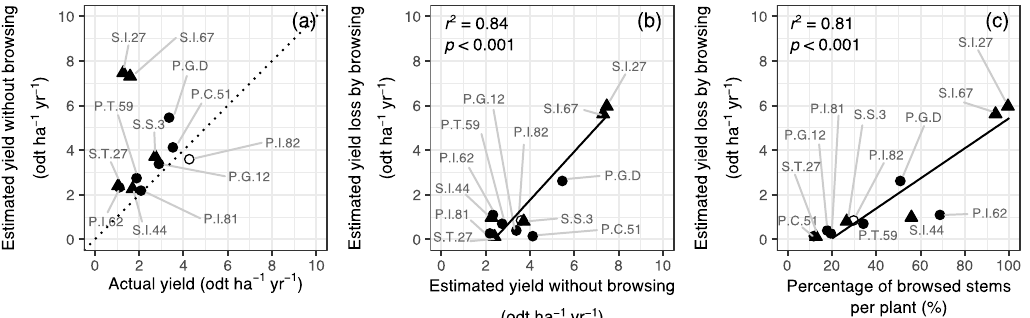
Figure 5. Relationships between actual and estimated yield without deer browsing ( a ), between estimated yield without browsing and estimated yield loss due to browsing ( b ), and the percentage of browsed stems per plant and estimated yield loss due to browsing ( c ) across willow clones. An open symbol represents the clone that was determined to be an outlier based on the GLM residuals. Clone names are shown. The coefficient of determination ( r 2 ), level of significance ( p ), and significant regression line of the standardized major axis analyses for the 11 clones excluding an outlier clone are shown. The dotted line in panel ( a ) represents a 1:1 relationship. odt, oven dry ton.